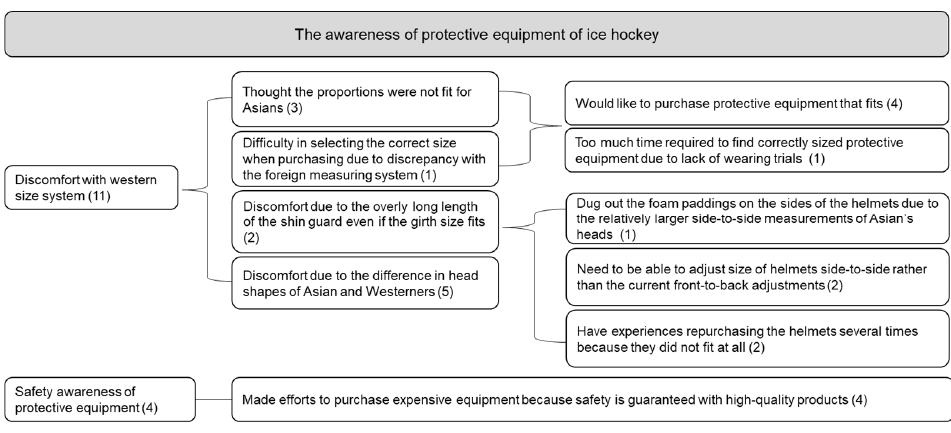
Figure 4. The awareness of protective equipment for ice hockey (coding number in parenthesis).